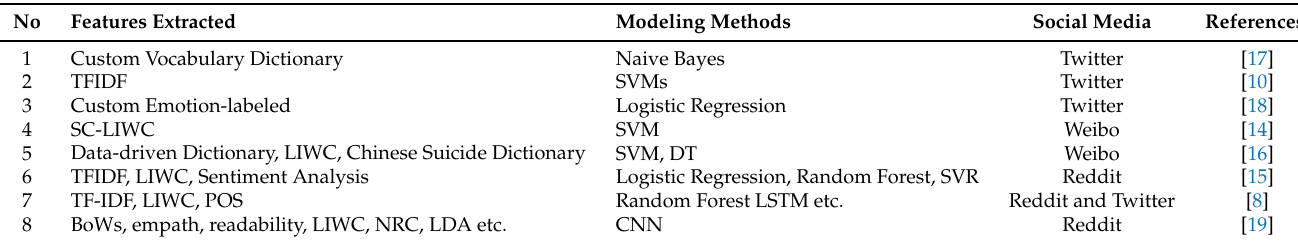
Table 1. A review of different suicide ideation detection studies on social